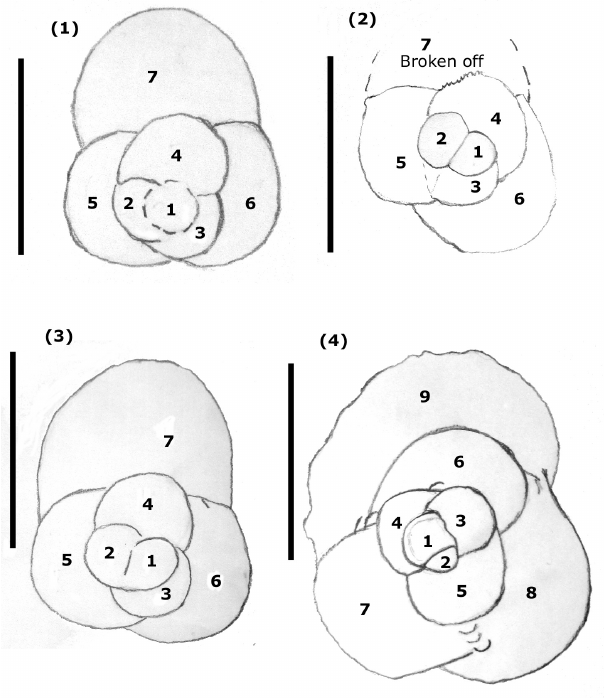
Figure 11. Triserial coiling mode in Mermaidogerina loopae